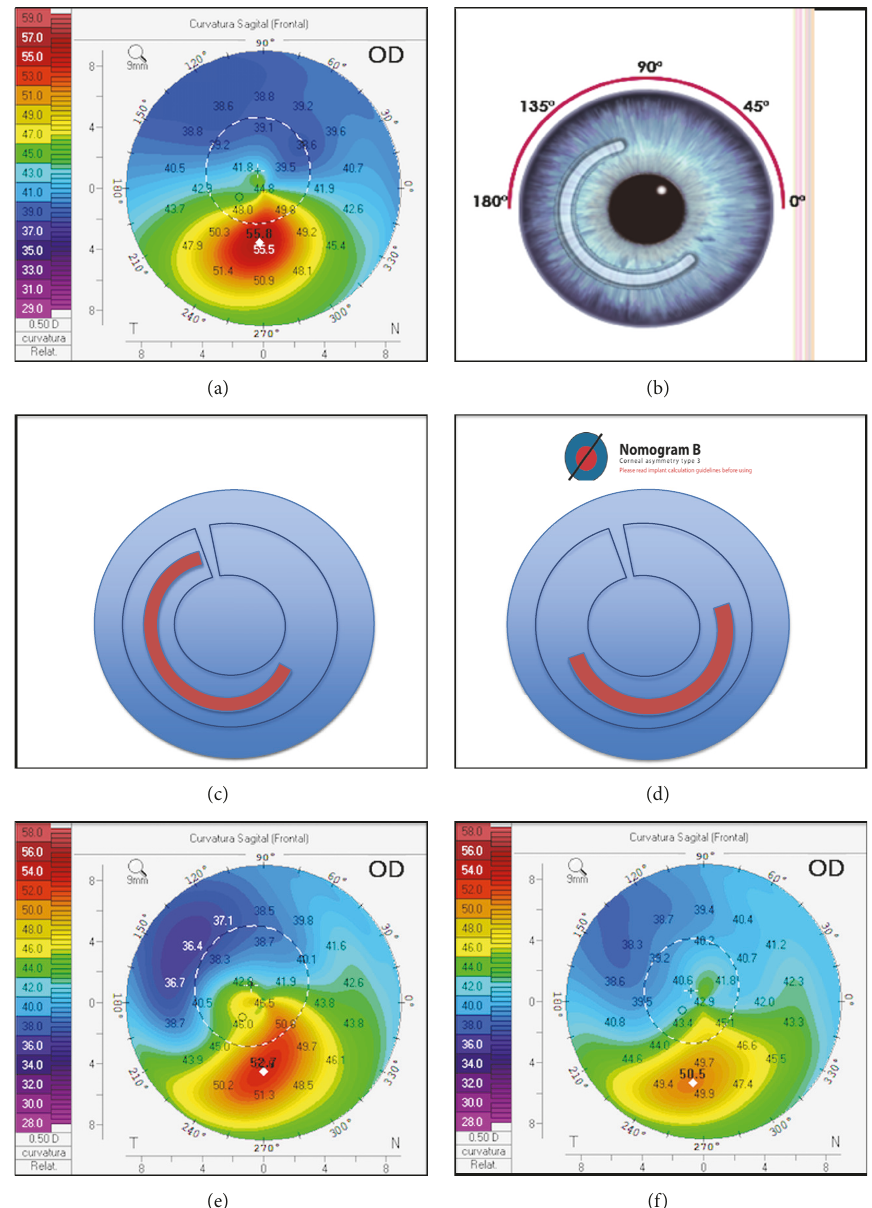
Figure 1: (a) Topography pretreatment. (b) Ferrara nomogram. (c) First intrastromal ring position. (d) KeraRing nomogram position. (e) One-month postimplantation ring position. (f) One-year postmodification ring